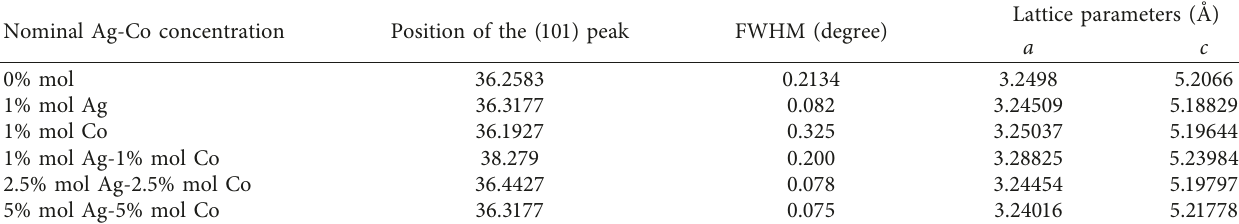
Table 1: Position, FWHM, and the lattice parameters of Zn